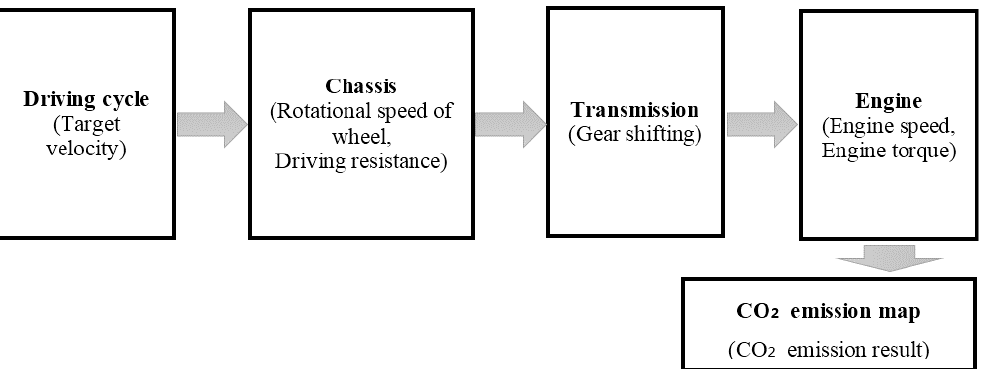
Figure 1. Calculation flow of the medium- and heavy-duty vehicle (MHDV) simulation.